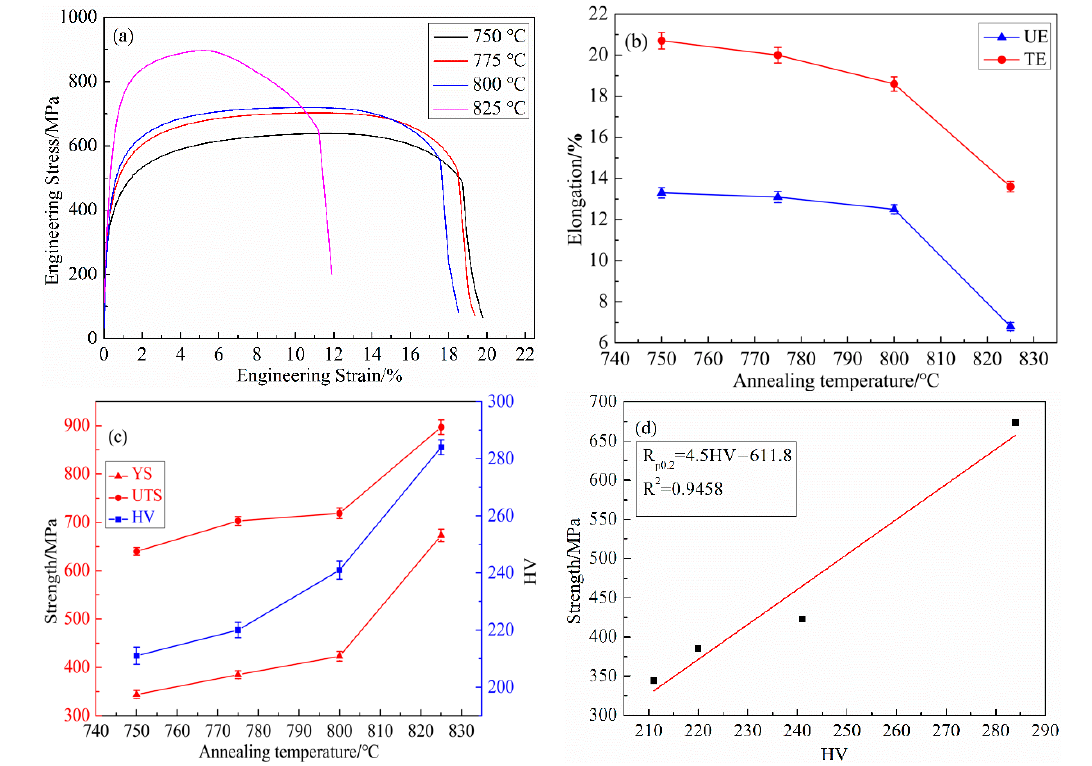
Figure 6. Mechanical properties of LH800 steel at different temperatures for 15 min followed by air quenching. ( a ) Engineering stress–strain curves of LH800. ( b ) Changes in elongation of LH800. ( c ) Changes in yield strength, tensile strength, and Vickers hardness of LH800. ( d ) The relationship between yield strength and Vickers hardness. (UE: uniform elongation; TE: total elongation; YS: yield stress; UTS: tensile stress; HV: Vickers hardness.)